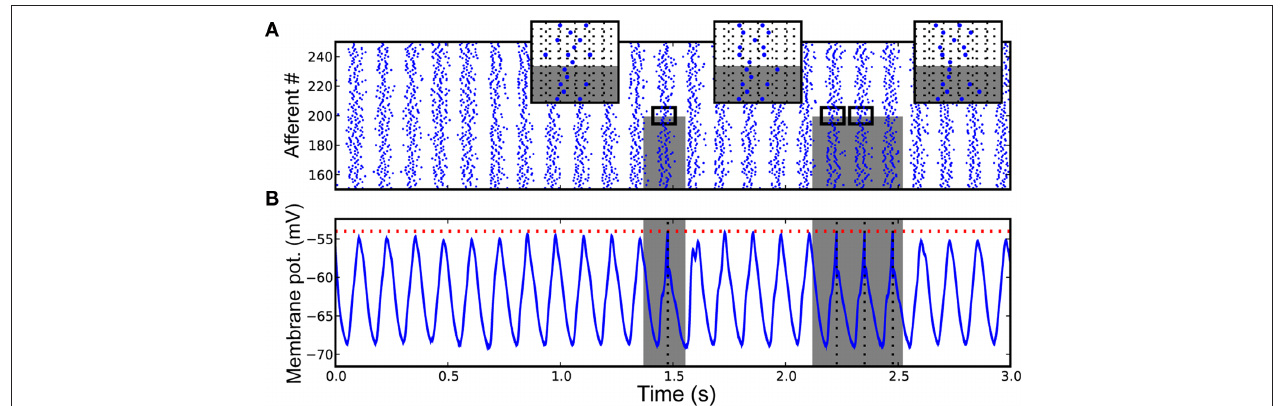
presentations, which is not true for other afferents (200, …, 1999 here). The repetition of the pattern spike wave allows the pattern to be learned by STDP. (B) Postsynaptic membrane potential as a function of time: it oscillates at the same frequency as the afferents (and possibly with a phase lag due to conduction delays), but reaches the threshold if and only if the pattern is presented. See Masquelier et al. (2009) for details. Figure adapted from Masquelier et al.